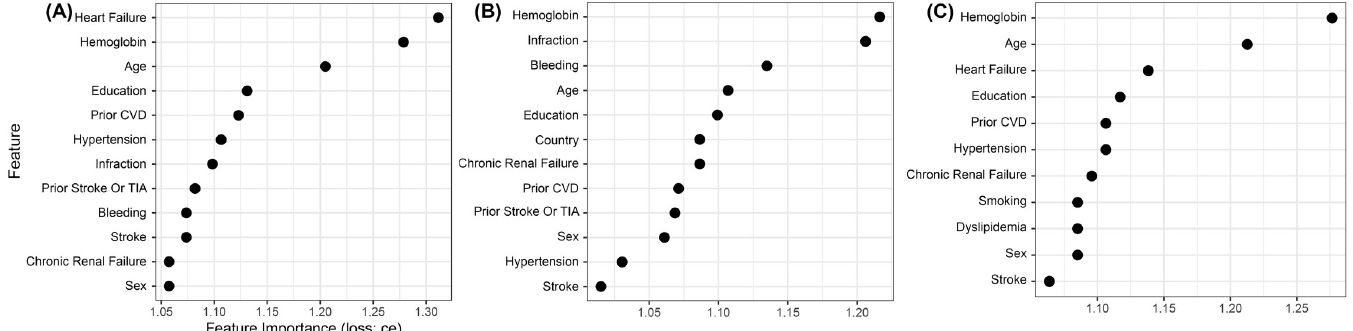
Fig 1. Important Features that Contribute to the Prediction of Three In-Hospital ACS Related Outcomes, Including (A) mortality, (B) heart failure, and (C) Bleeding. A classification error loss function (“ce”) was used to calculate feature importance. Black dots indicate median “ce,”. CVD: Cardiovascular disease. TIA: Transient ischemic